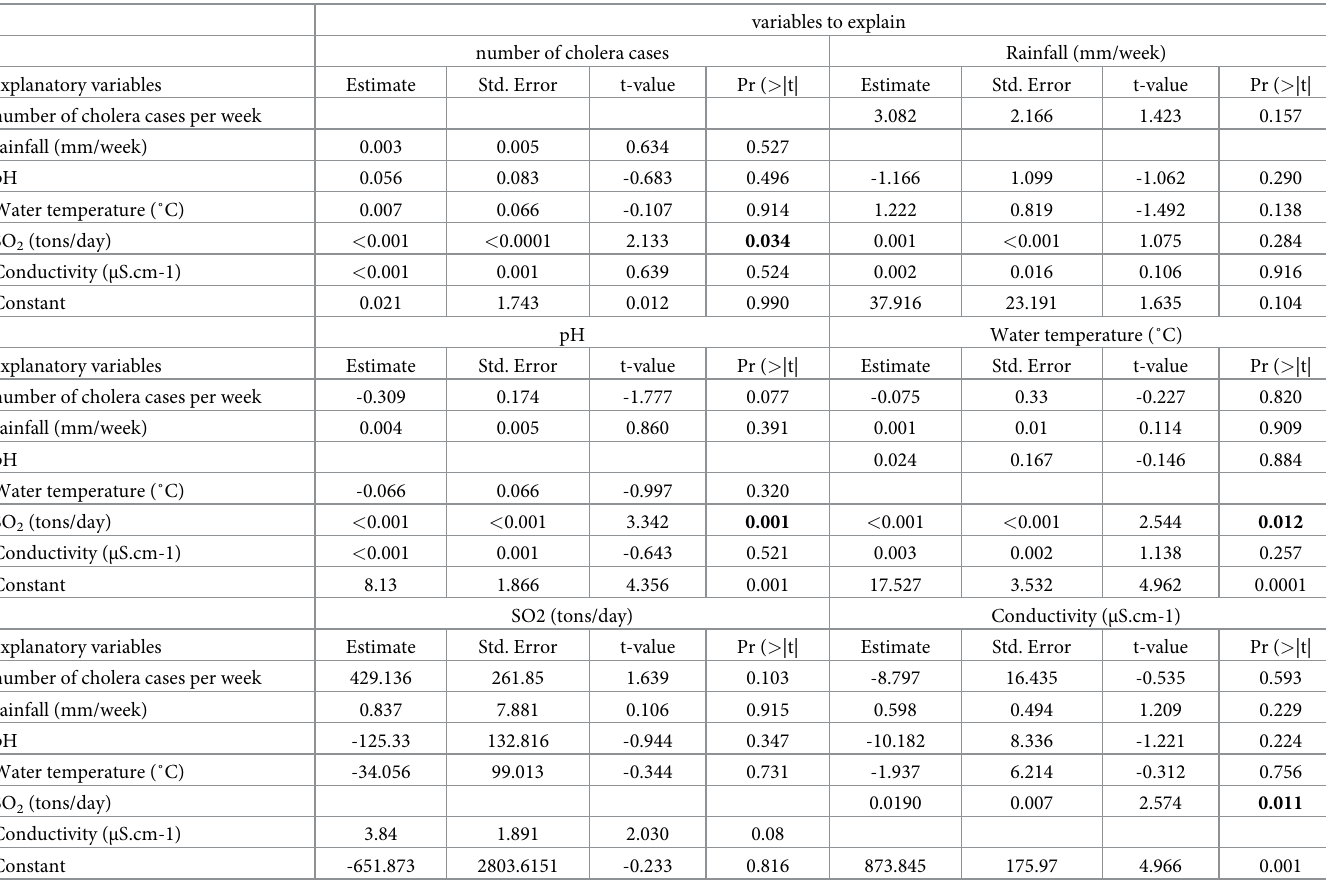
Table 4. Linear interdependencies among multiple time series using multivariate Vector Autoregression (VAR) models. Six variables were selected to build this model: cholera cases. rainfall. water temperature. water electric conductivity. pH. volcanic sulphur dioxide emission. For the 2007–2012 period. Katana Halth Zone. DR Congo (n = 147 sampled dates). The significant correlations are